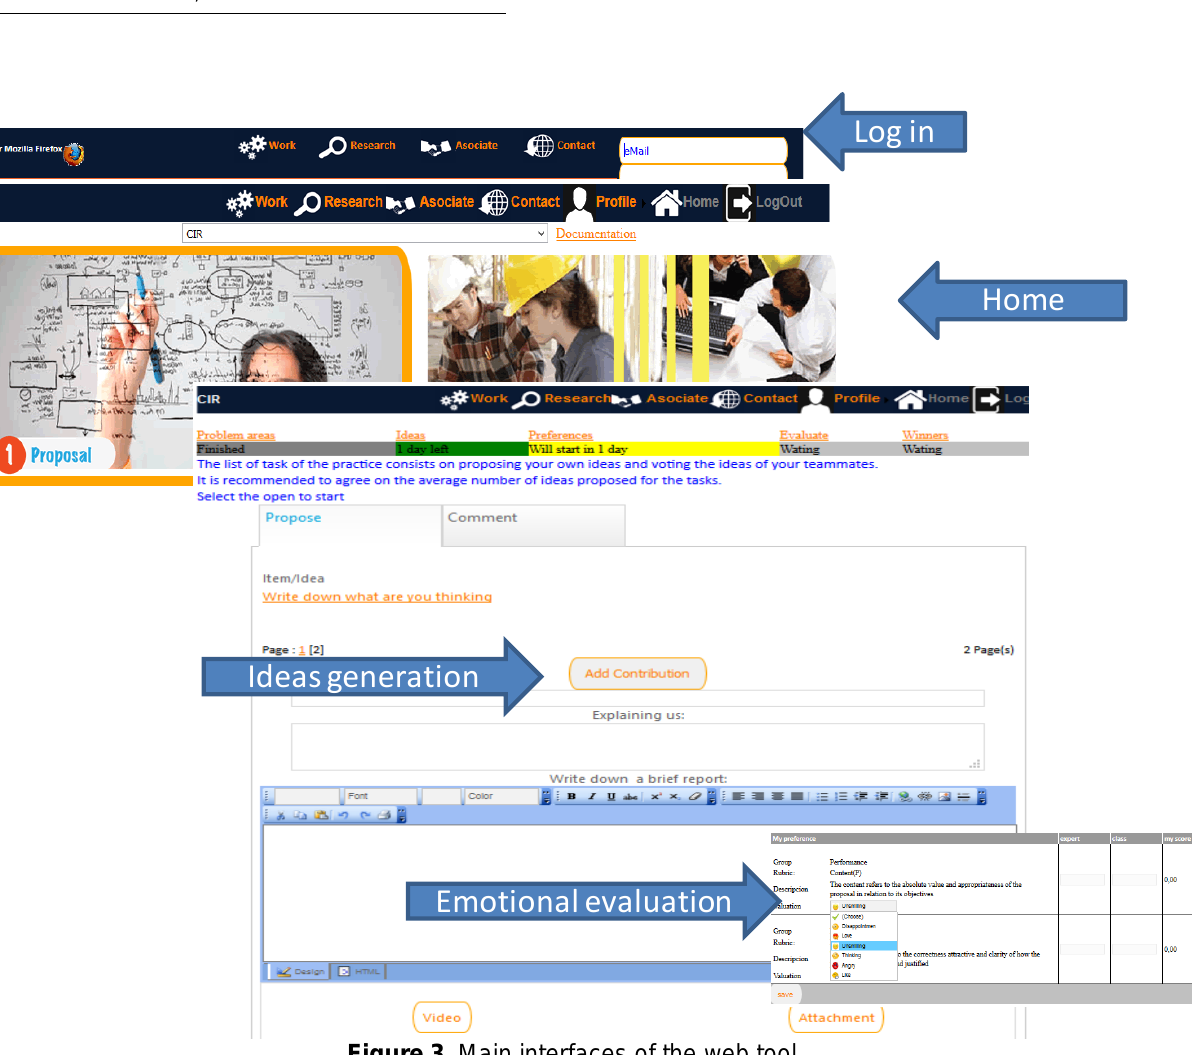
Figure 3 . Main interfaces of the web